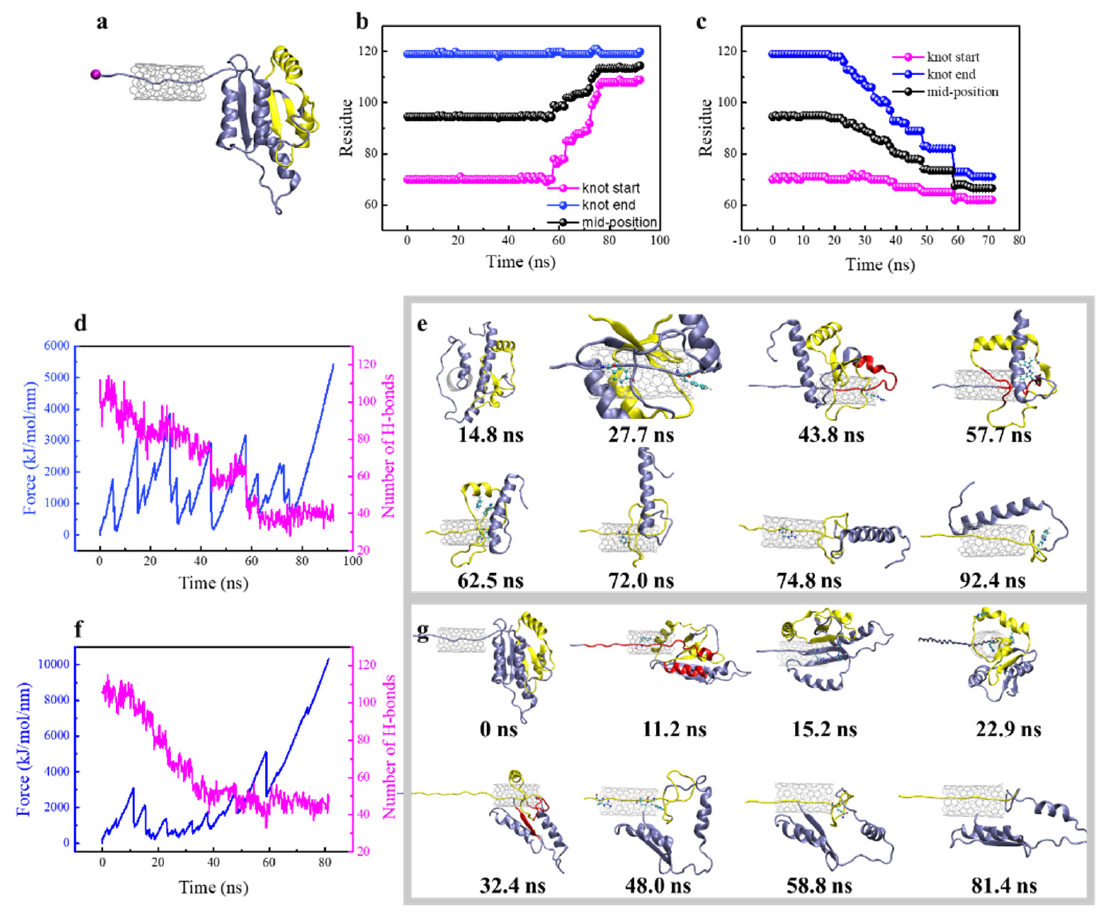
Figure 4. Steered MD simulation of YbeA translocation through SWCNT. ( a ) The simulation system setup illustrating the steered protein translocation through SWCNT. ( b , c ) Sequential movement of two knot termini and mid-position for YbeA when the N- ( b ) and C-terminal ( c ) were pulled through SWCNT. ( d ) Time evolutions of the pulling resistant force and hydrogen bond number when pulling the N-terminal through SWCNT. ( e ) Time sequence of typical snapshots depicting the protein structural response to generate resistant forces identified in ( d ). ( f ) Time evolutions of the pulling resistant force and hydrogen bond number when pulling the C-terminal through SWCNT. ( g ) Time sequence of typical snapshots depicting the protein structural response to generate resistant forces identified in ( f ).